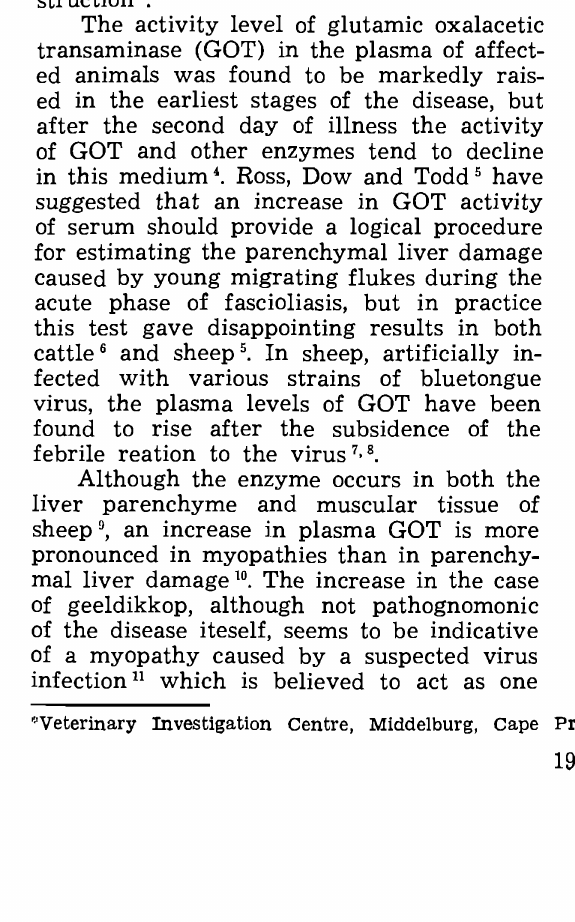
"Veterinary Investigation Centre, Middelburg, Cape